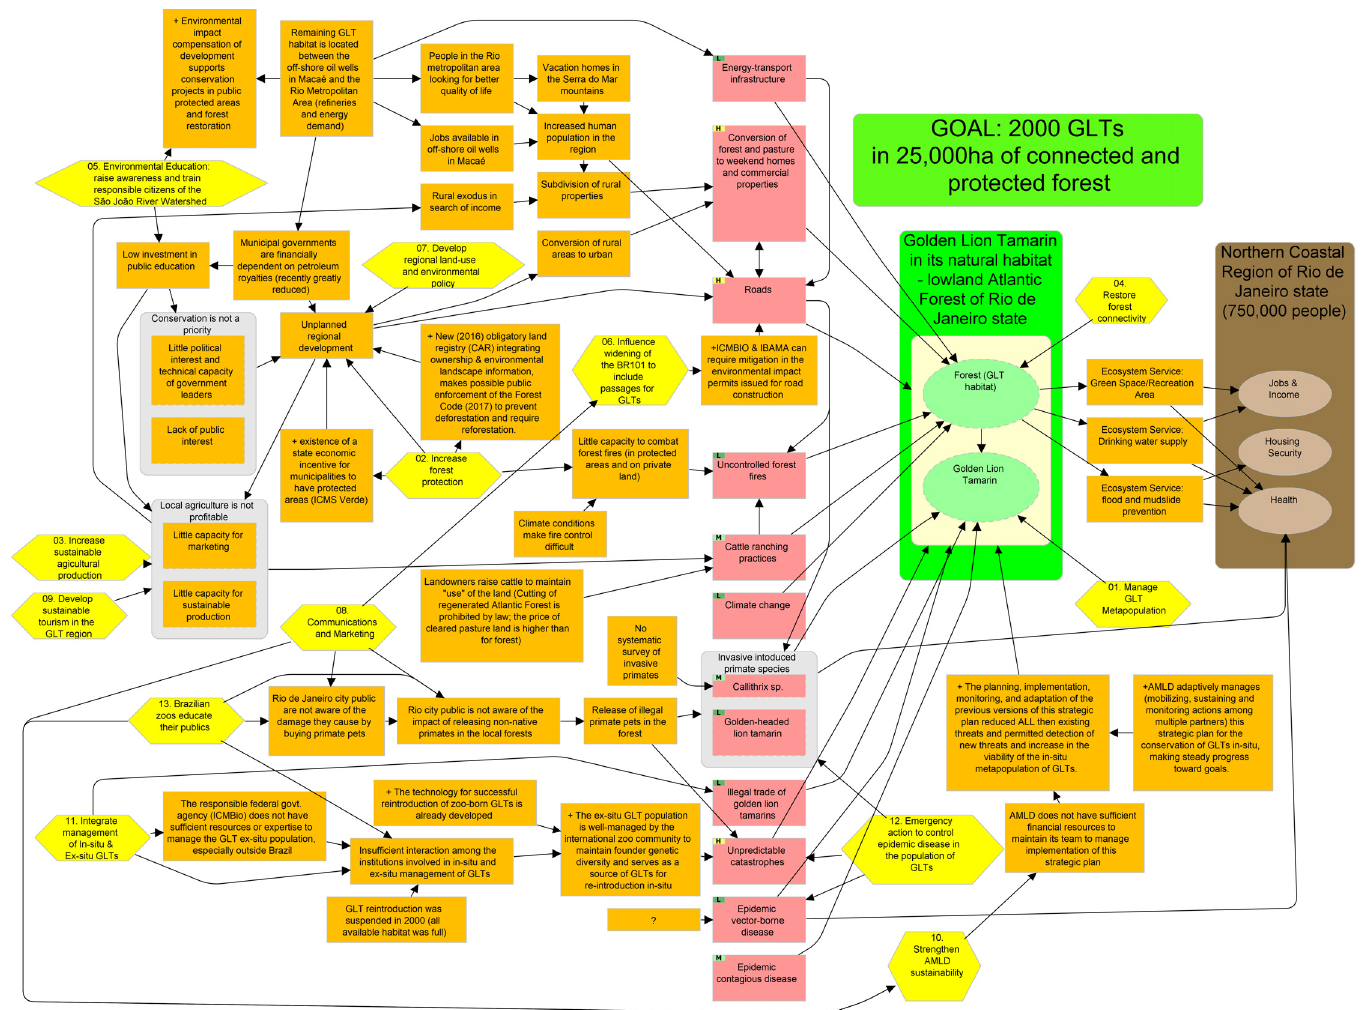
Fig 4. Conceptual model of the 2016–2025 strategic plan for conservation of golden lion tamarins (Version 18 October 2018, translated from Portuguese). Conceptual model showing elements of AMLD’s strategic plan to achieve a viable population of GLTs including the project scope (green rectangle) containing two conservation targets (ovals) and AMLD’s desired conservation outcome (blue rectangle), direct human-caused threats (purple rectangles), contributing factors such as indirect threats or opportunities (small brown rectangles), strategies with actions that have a common focus (yellow hexagons), and benefits to humans that result from GLT conservation (large brown rectangle). Arrows represent presumed causal relationships. The diagram was produced using Miradi project management software.